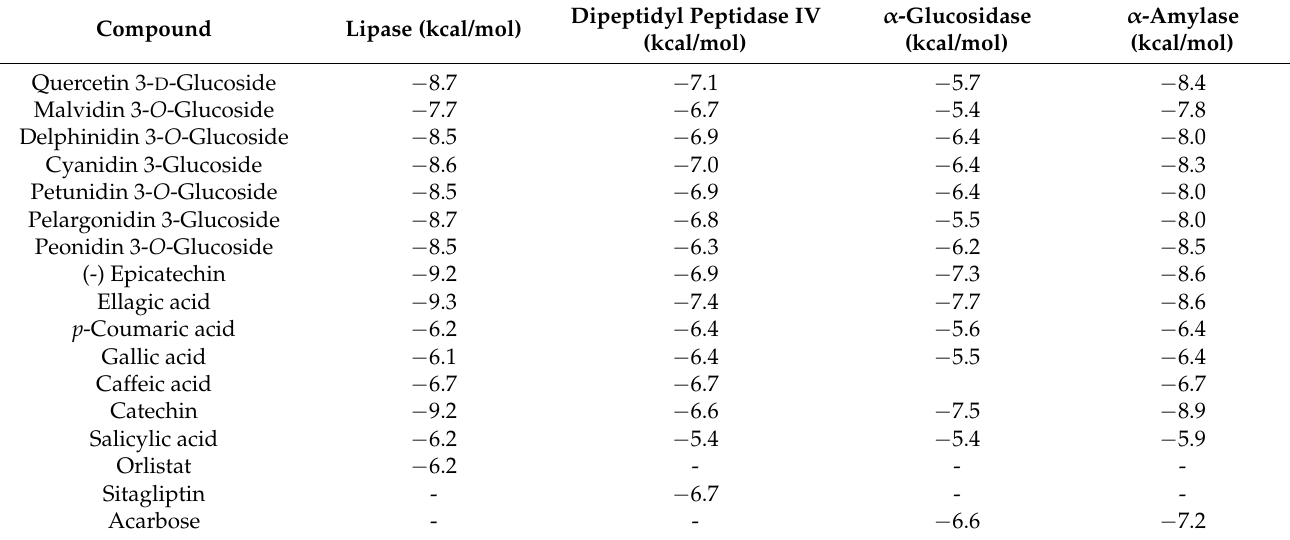
Table 3. Molecular docking predictions.